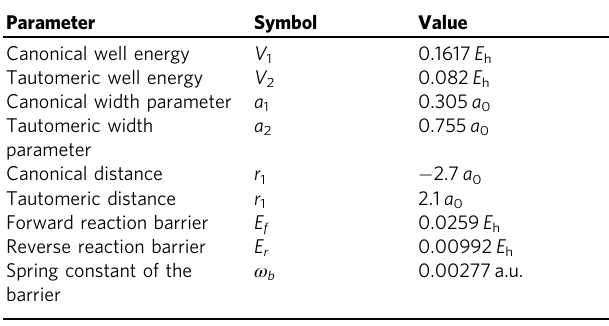
Table 1 contains all the parameters de fi ning the potential corresponding to the tautomerisation reaction of G – C.